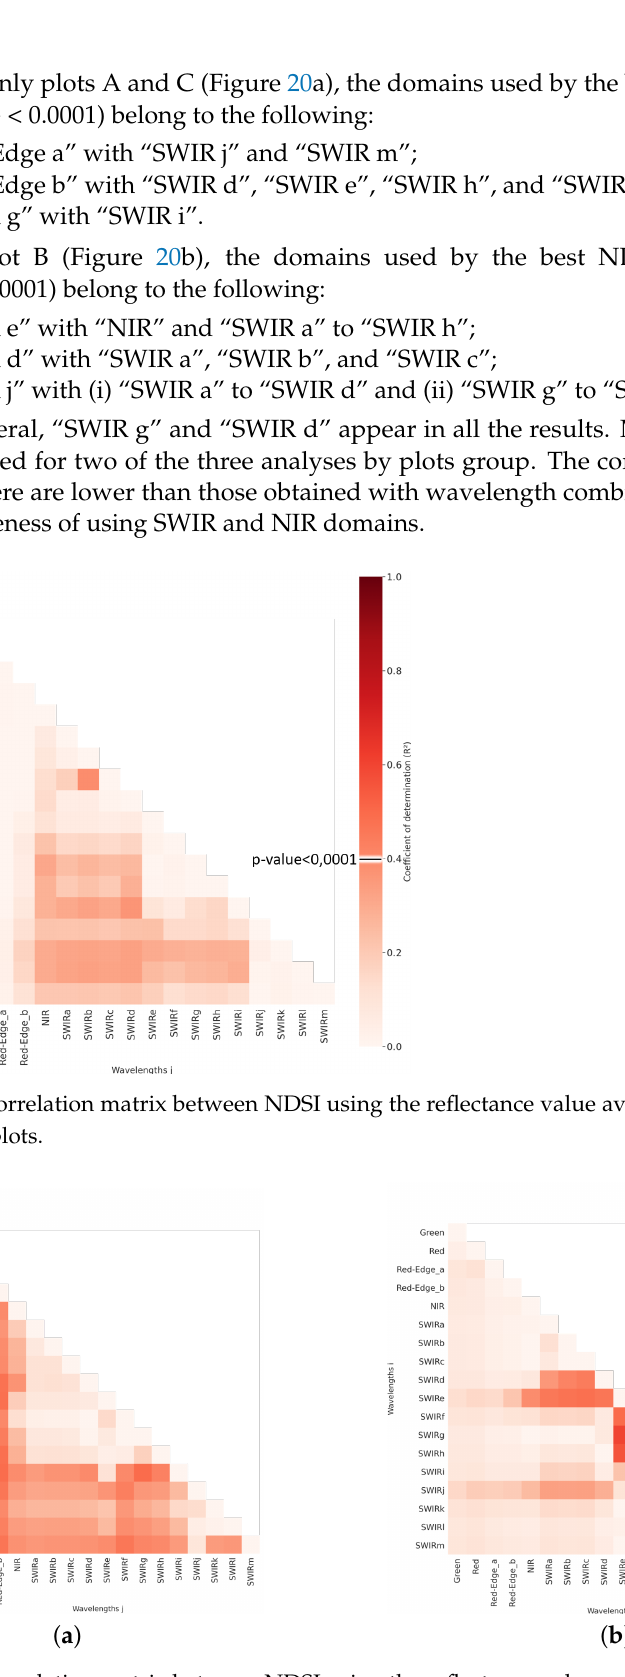
Figure 20. Correlation matrix between NDSI using the reflectance value average by domains and SWP for plots A and C and plot B. ( a ) Plots A and C. ( b ) Plot